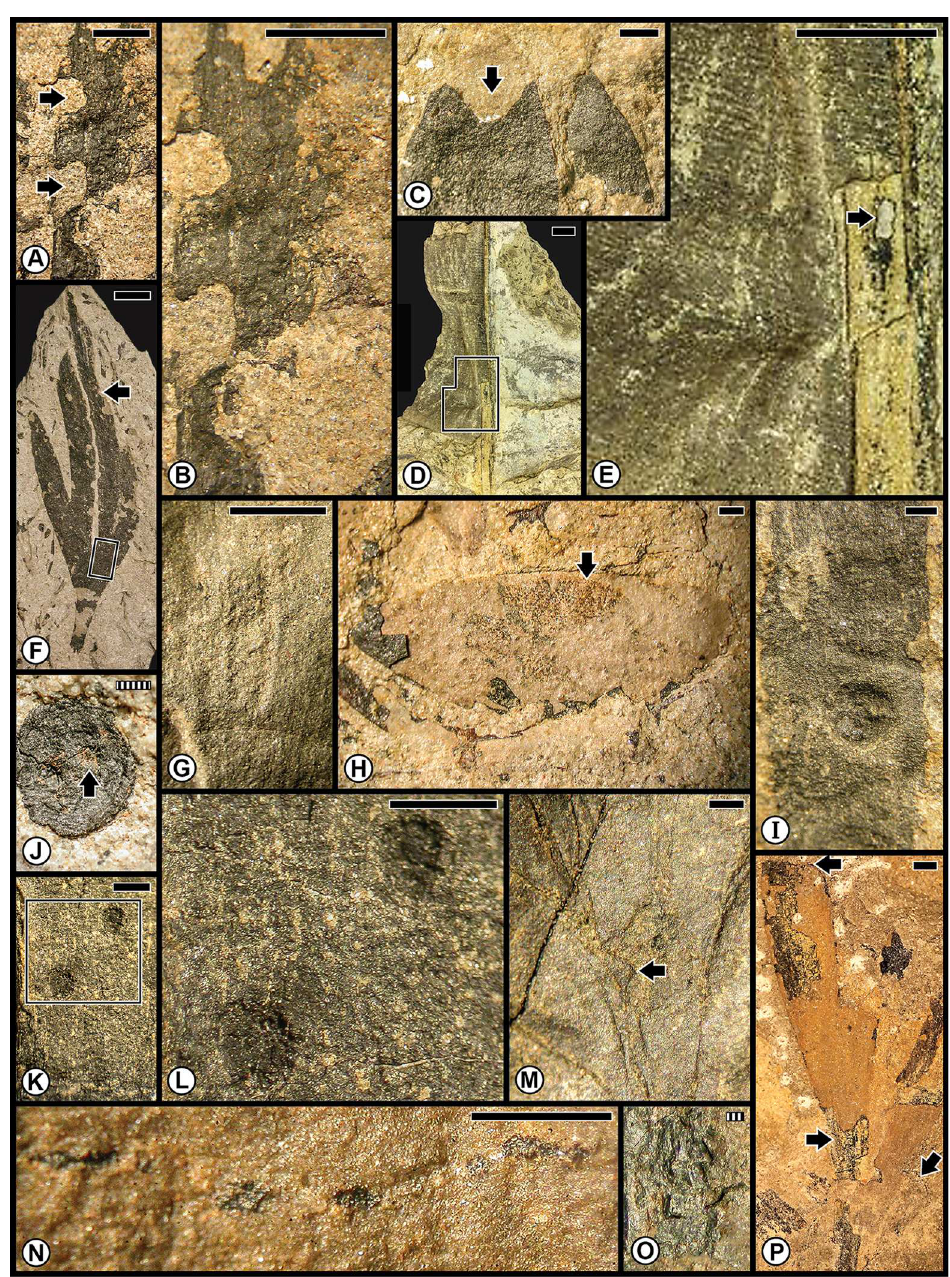
Fig 5. Plant–insect interactions from the Lopingian (Wuchiapingian) Gro¨den/Val Gardena Flora, of the Gro¨den/Val Gardena Sandstone at Bletterbach Gorge in the western Dolomites. A : Two examples at left of margin feeding(DT12), indicatedby black arrows, on a degraded pinnuleof the unaffiliated plant Dicranophyllum sp. SpecimenPAL-997. B : Enlargement of (A), showingmargin reaction tissue. C : Margin feeding(DT13) on the pinnulartip of the conifer Ortiseia leonardii . SpecimenPAL-2020. D : An undetermined cycadophyte, showingan ovipositionmark (DT76) on rachis, encompassed by polygonal template at left. Specimen PAL-1532. E : Enlargedimage of ovipositionmark in (D). The rachial epidermal apparently is absent. F : the ginkgophyte Sphenobaiera nutzmani exhibiting margin feeding (DT12) at top (black arrow) and surface feeding (DT130) below in the rectangulartemplate. Specimen PAL-445. G : A magnifiedversion of DT130 at (F), showingconsumption of surface tissues. H : The pteridophyte Sphenopteris sp. 1 pinnule showingsurface feedingdamage (DT30), indicatedby the roughenedsurface. PAL-1455. I : A globose gall (DT153) on the stem of the conifer Quadrocladus sp., indicatedby central bulbous tissue and radiating files of cells. SpecimenPAL-1464. J : Indeterminate, discoidal, platysperm seed with seed predation